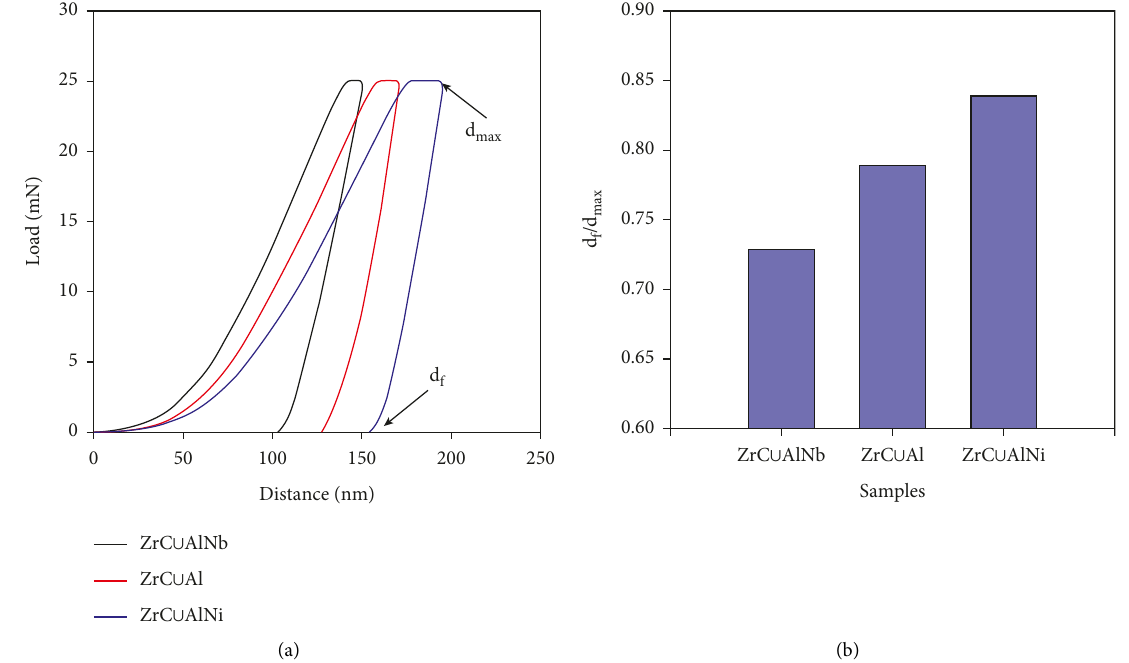
Figure 6: (a) Load-displacement curve and (b) d